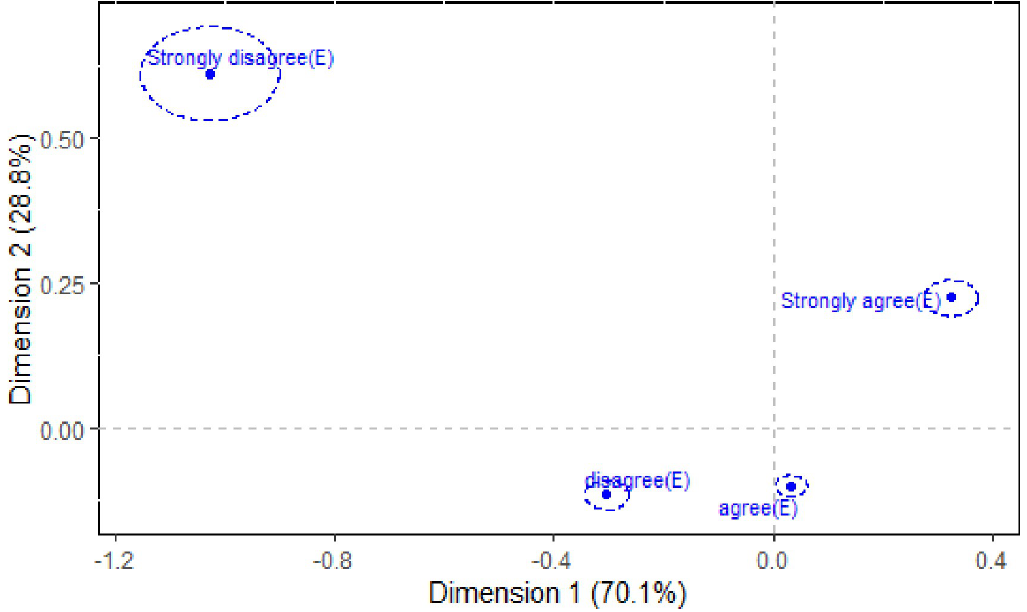
Fig 3. 95% Confidence ellipses for the Efficacy (E) variable of Table